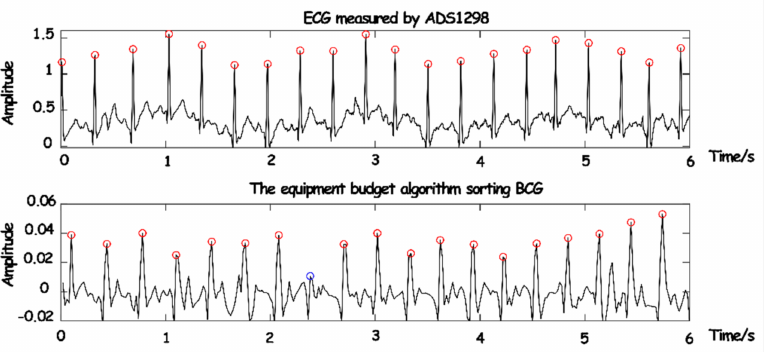
Figure 15. The synchronization comparison between BCG and ECG.